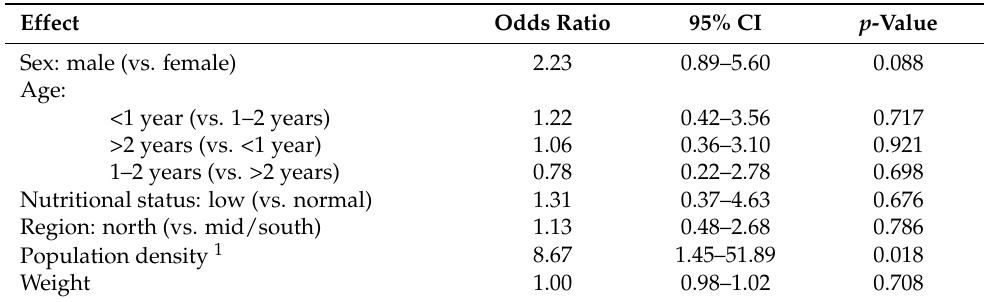
Table 2. Statistical associations of different attributes and the detection of ESBL-/AmpC-producing E. coli in fecal samples of wild